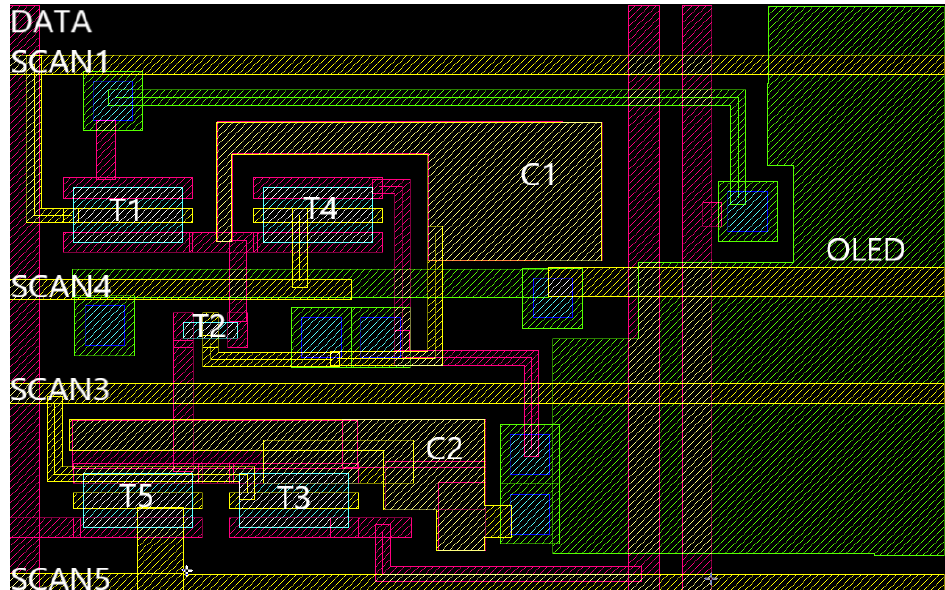
Figure 7. Layout structure of the circuit. Table 2. Comparison between this paper and the previous publications.